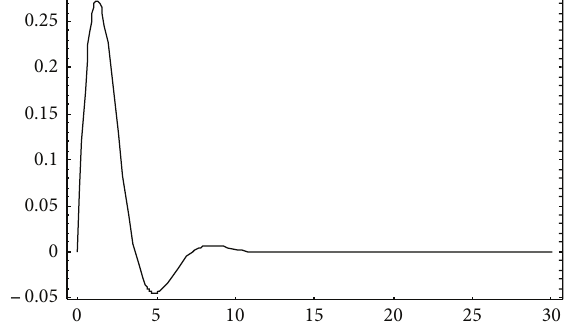
Figure 2: Phase plot of slave system.